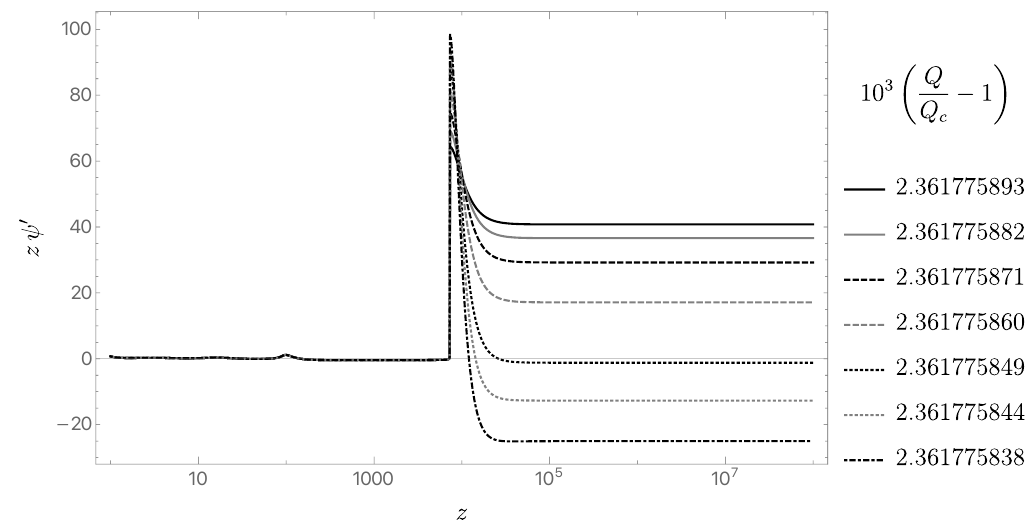
Figure 6 . Examples of Kasner transitions that are not described by (4.24). This is for α = 1 , q = 0 . 5 m, mM = 1 . 0 and several values of Q/Q c (see legend caption) In all cases, the initial constant value of β = zψ 0 before the transition is close to − 0 . 42 . Note the high sensitivity of the curves to a small change of Q/Q c